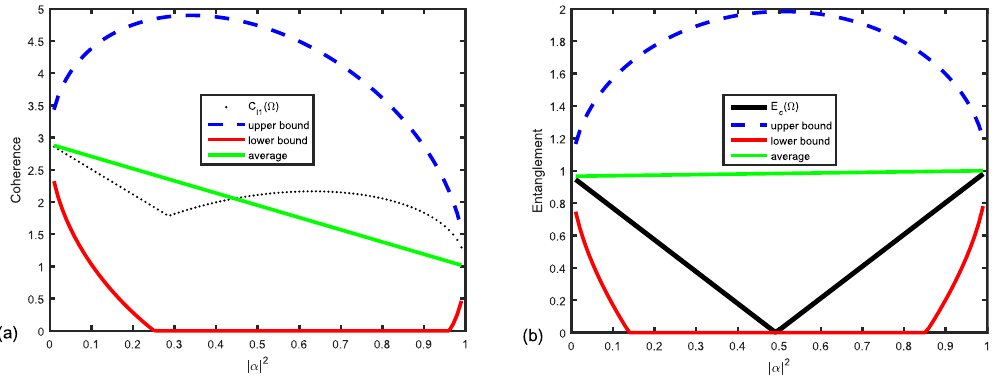
Figure 3. Bounds for l 1 coherence ( a ) and concurrence ( b ) of the two states in Eq. (24). In sub-figure ( a ), the black dotted line is the actual values of l 1 coherence, the blue dashed line is upper bound on l 1 coherence, the red solid line is lower bound on l 1 coherence, and the green line represents the statistical average coherence of the 2 2 superposed states, α β Φ + Ψ C C ( ) ( ) . In sub-figure ( b ), the black dotted line is the actual values of l l 1 1 concurrence, the blue dashed line is upper bound on concurrence, the red solid line is lower bound on concurrence, and the green line represents the statistical average entanglement of the superposed states, 2 2 . Note that coherence and entanglement are both α β Φ + C